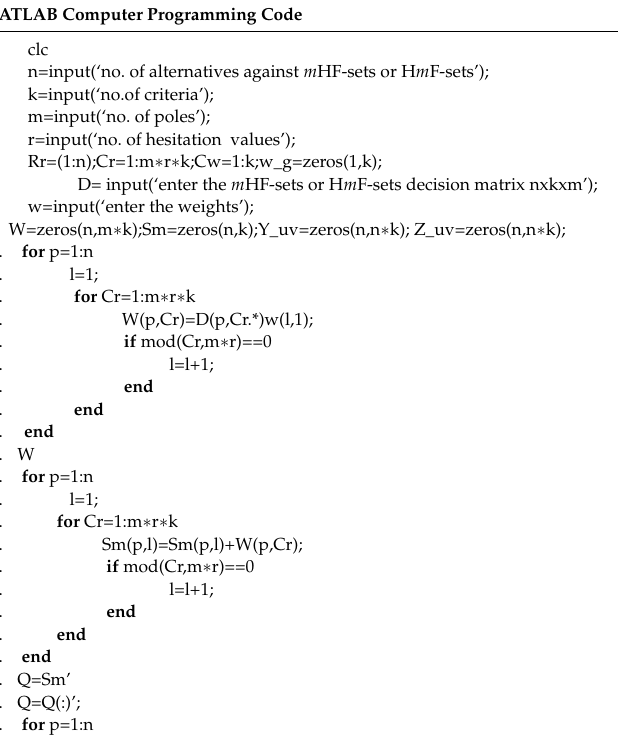
Table A1. MATLAB computer programming code of proposed approaches for